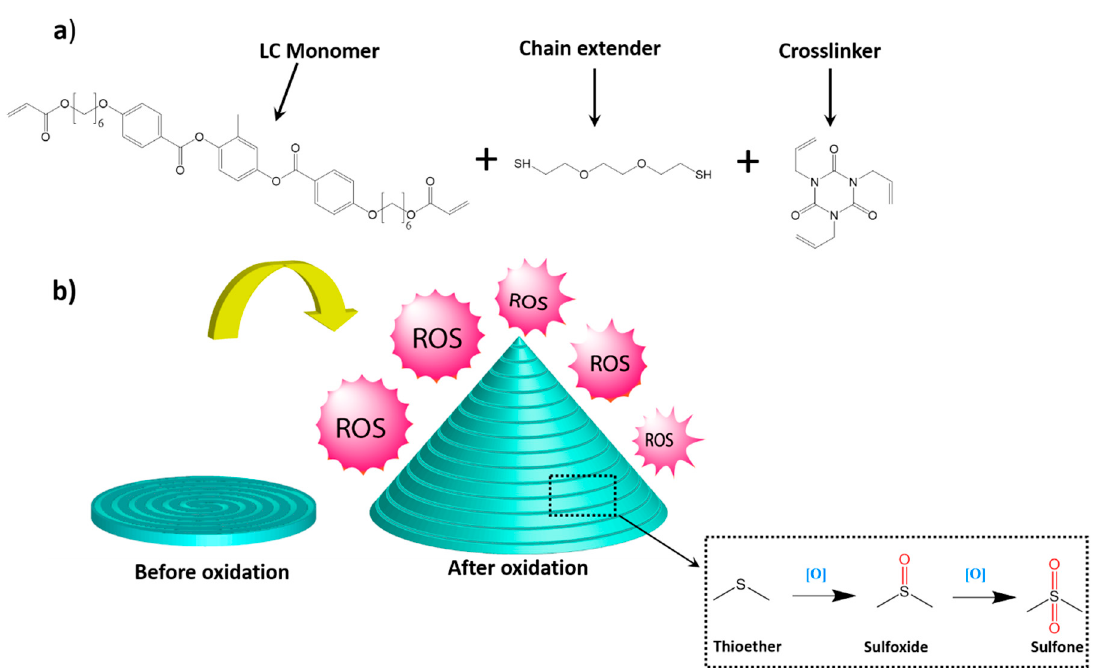
Figure 1. ( a ) Chemical structures of the liquid crystal (LC) monomer, (1,4-bis-[4-(6-acryloyloxhexyloxy)benzoyloxy]-2-methylbenzene (RM82)), thiol spacer, (2,2 ′ -(ethylenedioxy) diethanethiol (EDDT)), and the vinyl crosslinker, (1,3,5-triallyl-1,3,5-triazine-2,4,6(1H,3H,5H)-trione (TATATO)), used to synthesize the oxidation-responsive polymers. ( b ) Schematic of a reactive oxtgen species (ROS)-sensitive Liquid Crystal Elastomer (LCE) disc with a patterned molecular orientation morphing from a flat configuration to a complex 3D structure in the presence of ROS.